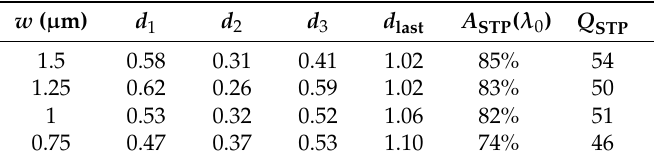
Figure 6. Resonance profile showing the relative field enhancement | E | / | E 0 | ( E 0 denotes electric field without TP structure) for ( a ) four layers (two etched air gaps) with w = 1 µ m and ( b ) six layers (three etched air gaps) with w = 1.5 µ m. The fields correspond to thickness configuration obtained via GA optimization featuring 1D TP structures (see Table 2). The higher electric field in panel (a) leads to an absorptance by silver of 82%, whereas in panel (b) the field corresponds to a peak absorptance of 90%. Table 3. Widths, relative absorption, and quality factors for the obtained GA optimized configurations using the fitness function (6) featuring STP structures. Four layers were varied for finding high fitness configurations at the target resonance wavelength λ 0 = 4.26 µ m.